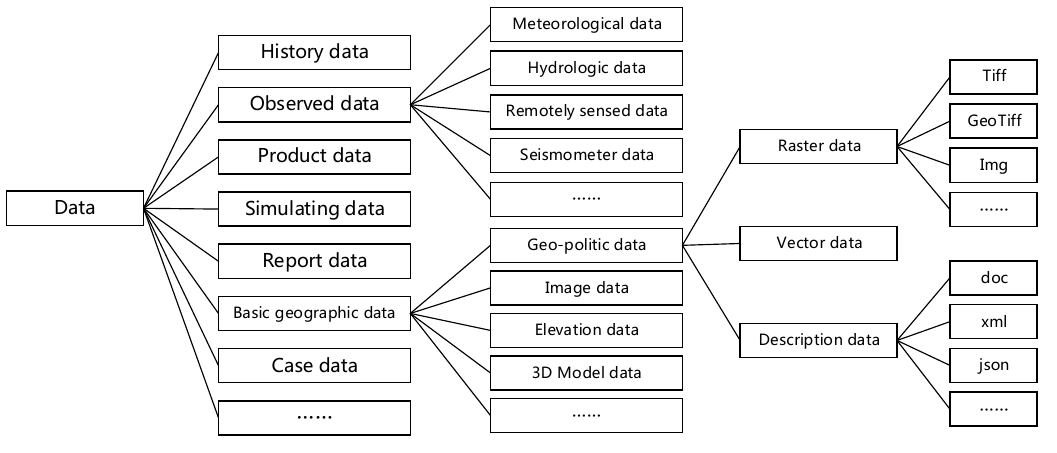
Figure 2. Disaster data